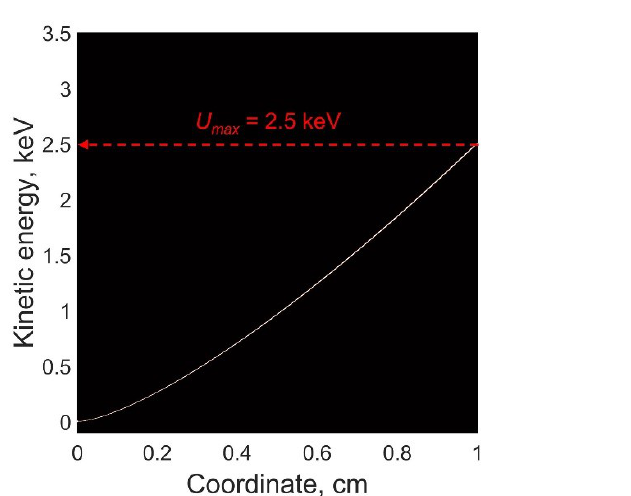
Figure 5 – Electron distribution function density plot at 4 ns (steady-state current flow